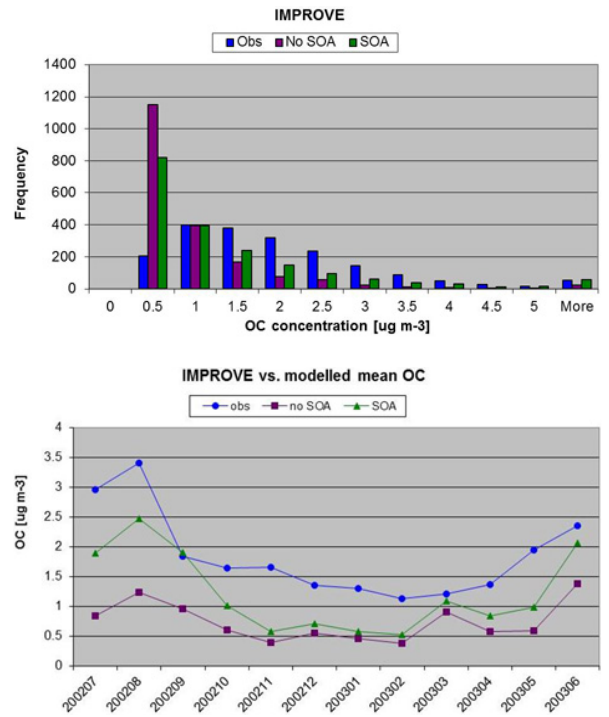
Fig. 13. IMPROVE observations and modelled OC aerosol